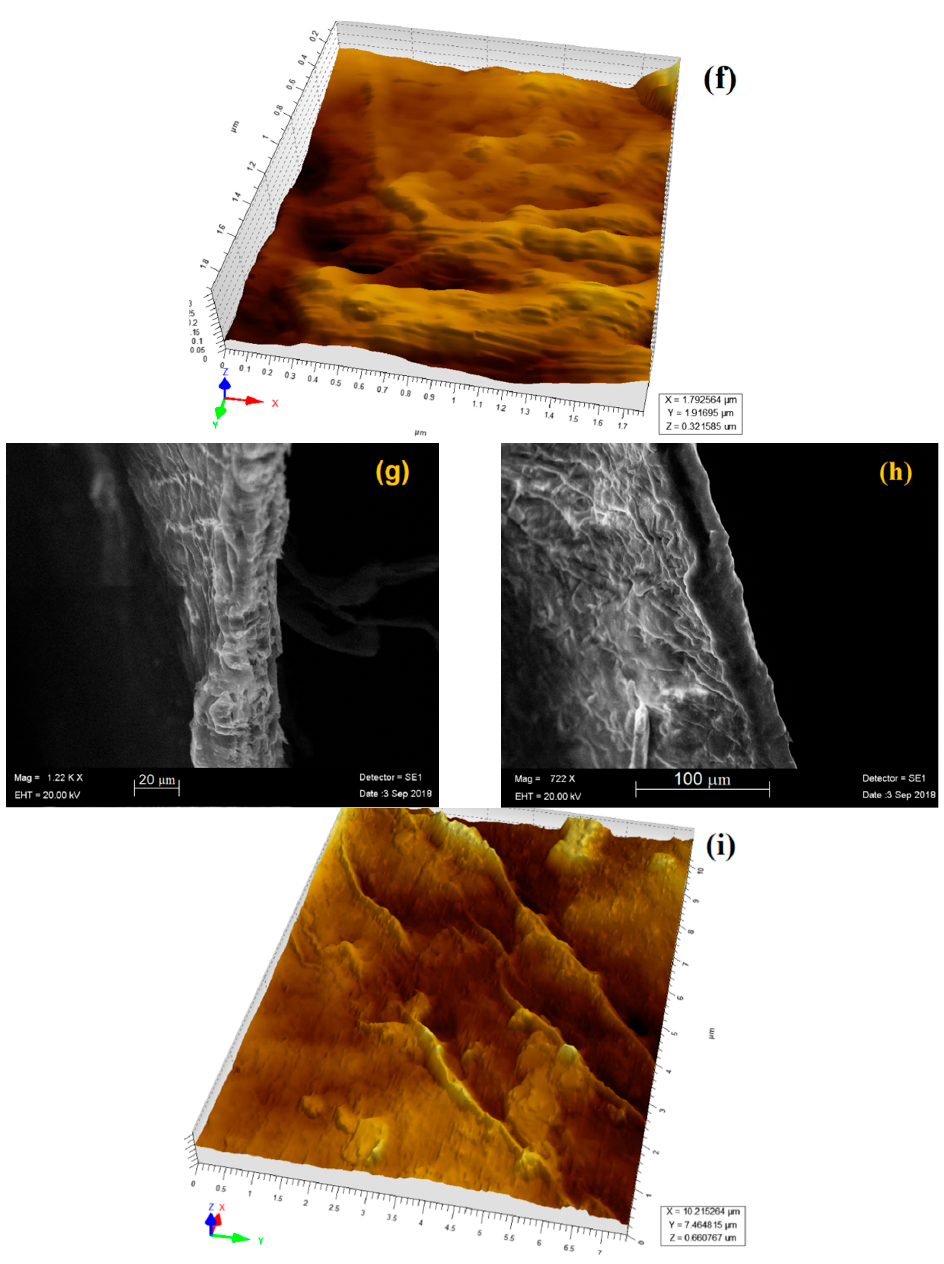
Figure 3. Cross-sectional scanning electron microscopy (SEM) images of different commercial collagen membranes before ( a,d,g ) and after ( b,e,h ) PRGF treatment; AFM 3D topography of the membrane surface after PRGF treatment ( c,f,i ) showing the details of collagen fibers. The images correspond to Biocollagen ® ( a – c ), Cova TM Max ( d – f ), and Jason ® ( g – i